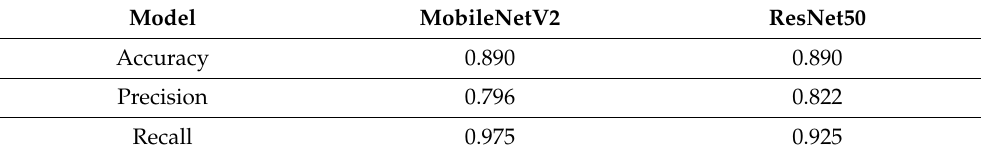
Table 4. Performances of the DL algorithms computed based on the washer classification.